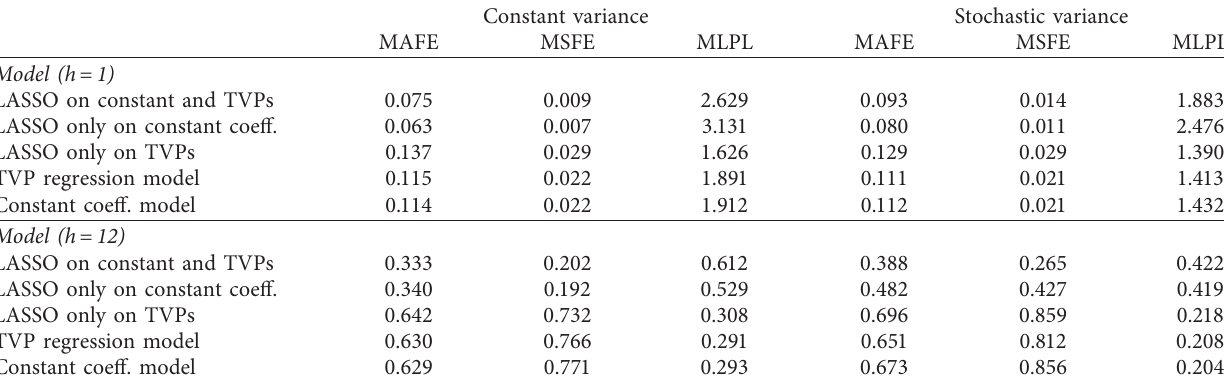
Table 11: Measures of forecast performance for log return of Brent with WTI